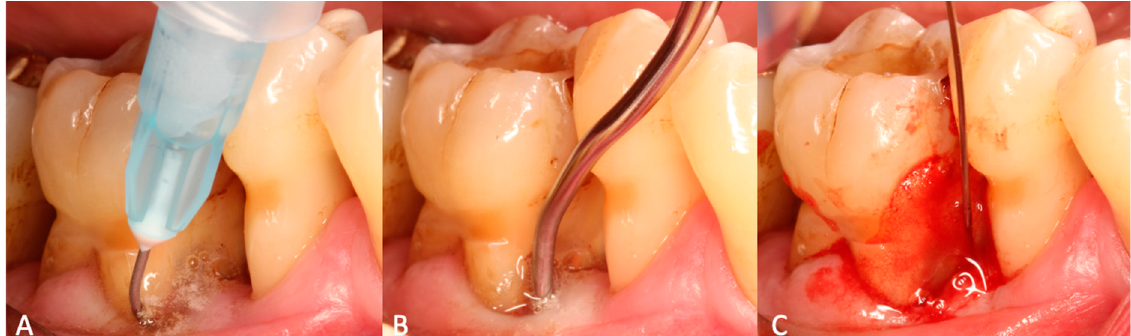
Figure 1. Visualization of the applied treatment protocol. ( A ) Application of chloramine gel to the pocket for 30–45 s. ( B ) Scaling and root planning is performed. Chloramine gel may be applied re- peatedly until non-surgical treatment is deemed sufficient. ( C ) Cross-linked hyaluronic acid (xHya) is applied to the pocket until